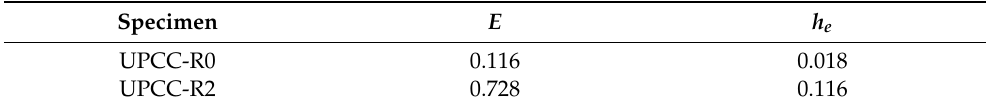
Table 6. Energy dissipation performance index.